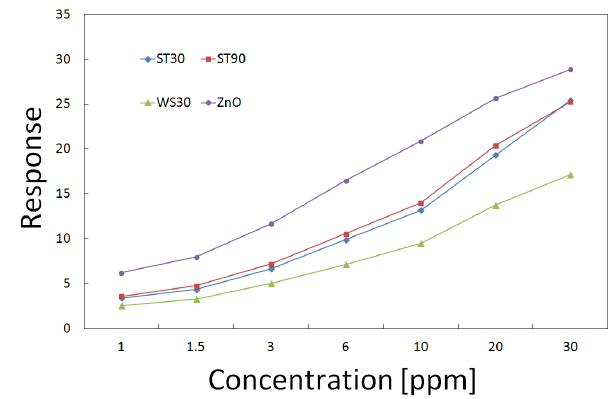
Figure 5. Responses vs. n-butanol from 1 to 30ppm dispersed in a dry carrier.